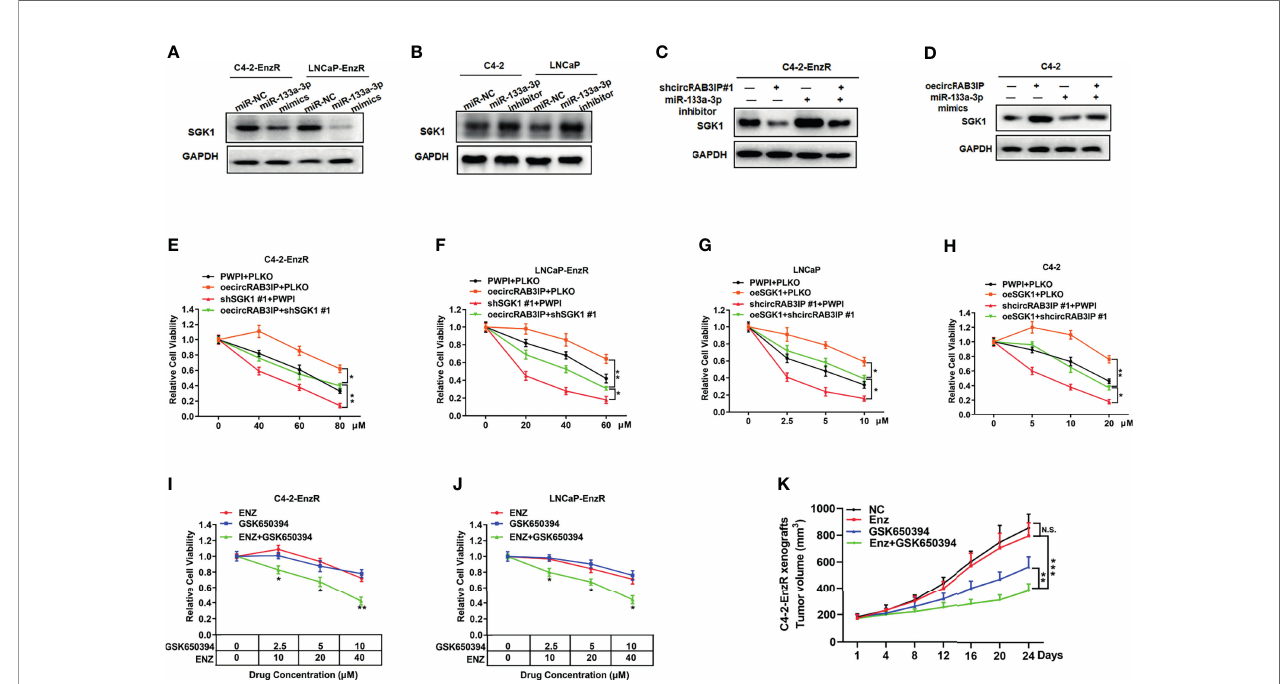
FIGURE 4 | (A) The protein levels of SGK1 were detected by WB after treatment with miR-133a-3p mimics in C4-2-EnzR and LNCaP-EnzR cells. (B) The protein levels of SGK1 were detected by WB after treatment with miR-133a-3p inhibitors in C4-2 and LNCaP cells. (C) The upregulation of SGK1 in C4-2-EnzR cells transfected with miR-133a-3p inhibitors was reversed by knocking down circRAB3IP, as detected by WB. (D) The downregulation of SGK1 in C4-2 cells transfected with miR-133a-3p mimics was reversed by overexpression of circRAB3IP, as detected by WB. (E) C4-2-EnzR cells were treated with different concentrations of Enz as indicated after overexpressing circRAB3IP, knocking down SGK1 or their combination, and cell viability was evaluated by CCK-8 assay. (F) LNCaP-EnzR cells were treated with different concentrations of Enz as indicated after overexpressing circRAB3IP, knocking down SGK1 or their combination, and cell viability was evaluated by CCK-8 assay. (G) LNCaP cells were treated with different concentrations of Enz as indicated after overexpressing SGK1, knocking down circRAB3IP or their combination, and cell viability was evaluated by CCK-8 assay. (H) C4-2 cells were treated with different concentrations of Enz as indicated after overexpressing SGK1, knocking down circRAB3IP or both in combination, and cell viability was evaluated by CCK-8 assay. (I) C4-2-EnzR cells were treated with different concentrations of Enz, GSK650394 or their combination as indicated, and cell viability was evaluated by CCK-8 assay. (J) LNCaP-EnzR cells were treated with different concentrations of Enz, GSK650394 or their combination as indicated, and cell viability was evaluated by CCK-8 assay. (K) Mice bearing C4-2-EnzR xenografts were treated with control, Enz, GSK650394 or their combination for 24 days, and tumor volumes were measured every 4 days. Data are presented